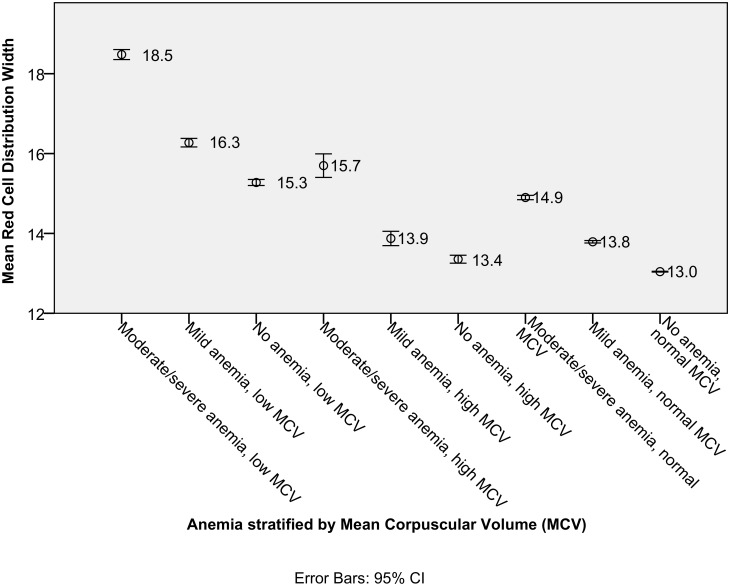
Graph showing the mean and 95% confidence intervals of red cell distribution width in various anemia / mean corpuscular volume (MCV) groups.